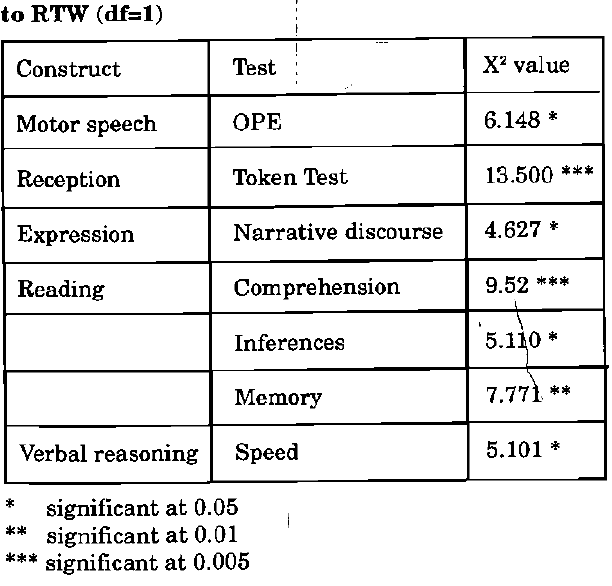
TABLE 4: Communicative tests significantly related to RTW (df=l)